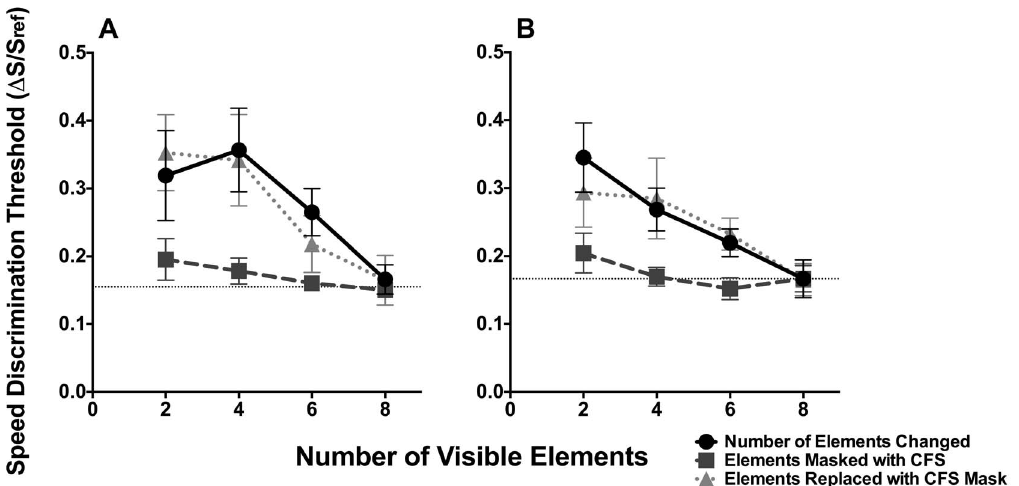
Fig. 3. Speed discrimination thresholds for translational motion (A) and rotational motion (B). Speed discrimination thresholds as Weber fractions plotted as a function of the number of elements visible in the stimulus. Circles depict data for conditions in which the actual number of elements in the stimulus was changed; diamonds - removed elements were replaced by a dynamic Mondrian patch; and circles elements are present but suppressed from awareness using CFS. Error bars represent 95% confidence